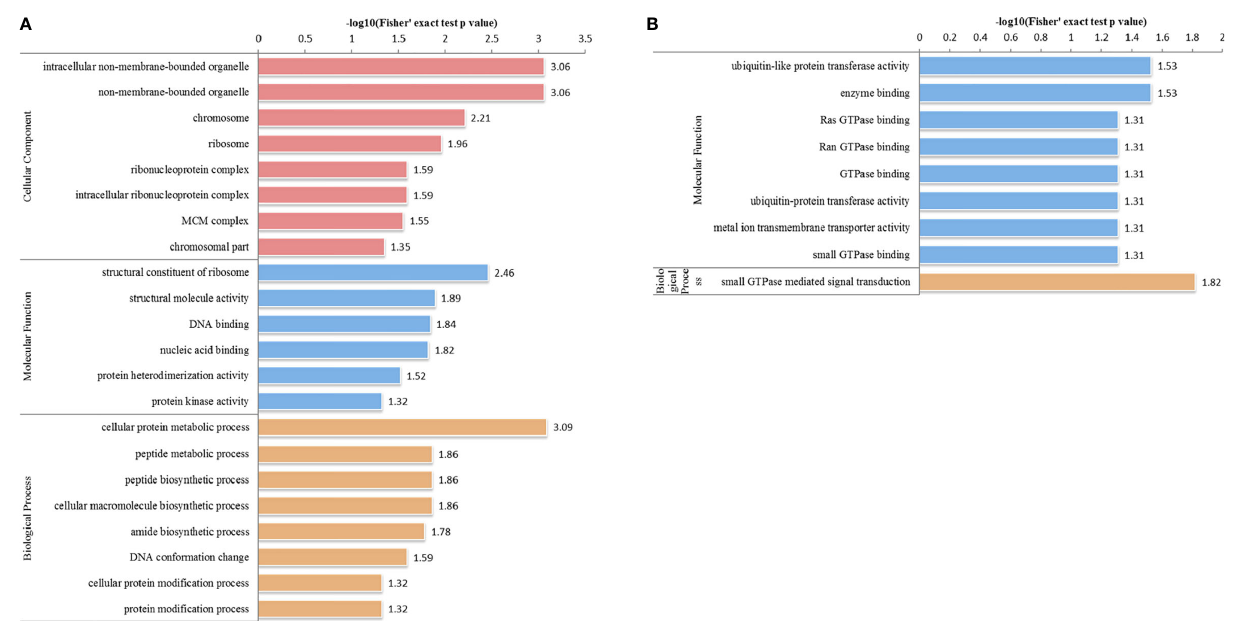
FIGURE 7 | GO analysis of DEPs in the HT vs . T group. The enriched GO terms under cellular component, biological process, and molecular function classi fi cations for (A) upregulated and (B) downregulated proteins.